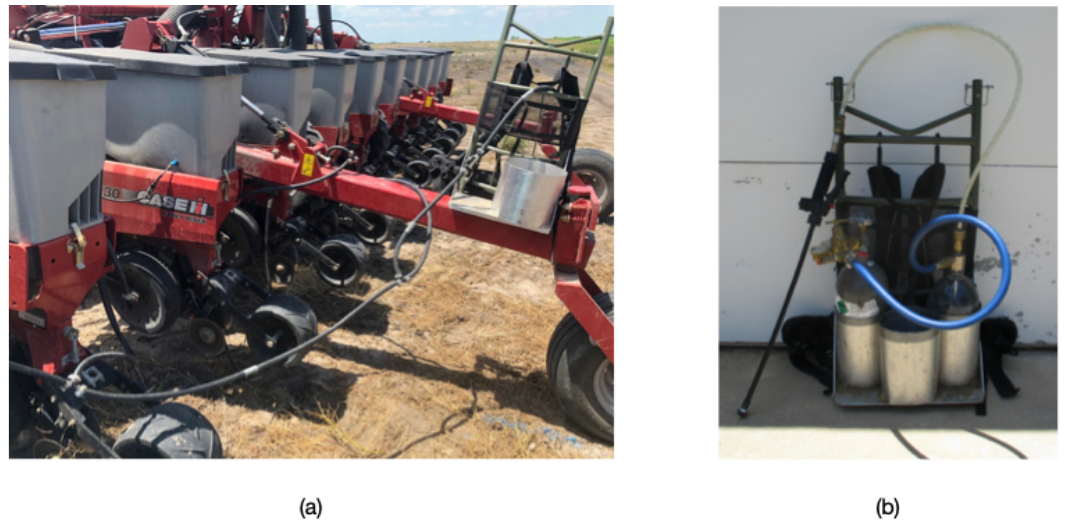
Figure 9. ( a ) A Case IH 1230 planter was used for in-furrow application; and ( b ) a CO 2 -pressurized backpack sprayer was used for manual treatments.